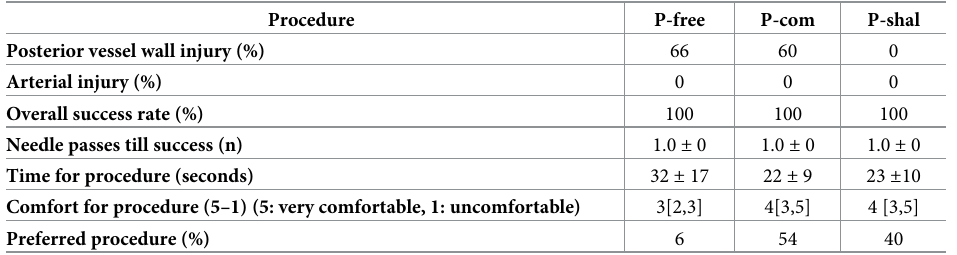
Table 2. Primary and secondary outcomes and questionnaire